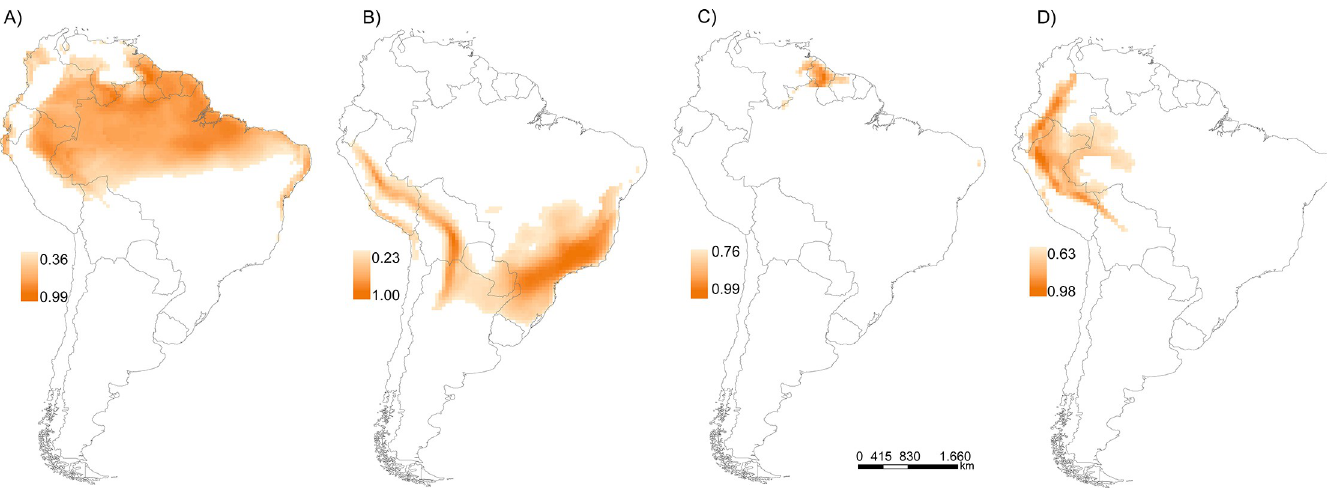
Fig 2. Habitat suitability and future geographic distribution. Consensus patterns of habitat suitability and potential future geographic distributions of the Micrurus lemniscatus complex after applying specific decision thresholds (the lowest presence threshold); A) Micrurus l . lemniscatus , B) Micrurus l . carvalhoi , C) Micrurus diutius , D) Micrurus l . helleri